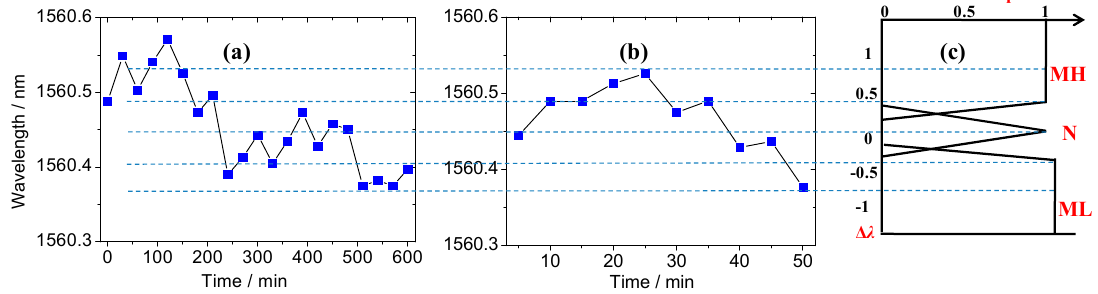
Figure 7. The wavelength shift of oscillation at 1560.46 nm in the ( a ) long term (600 min), ( b ) short term (50 min) and ( c ) the membership of λ -shift.